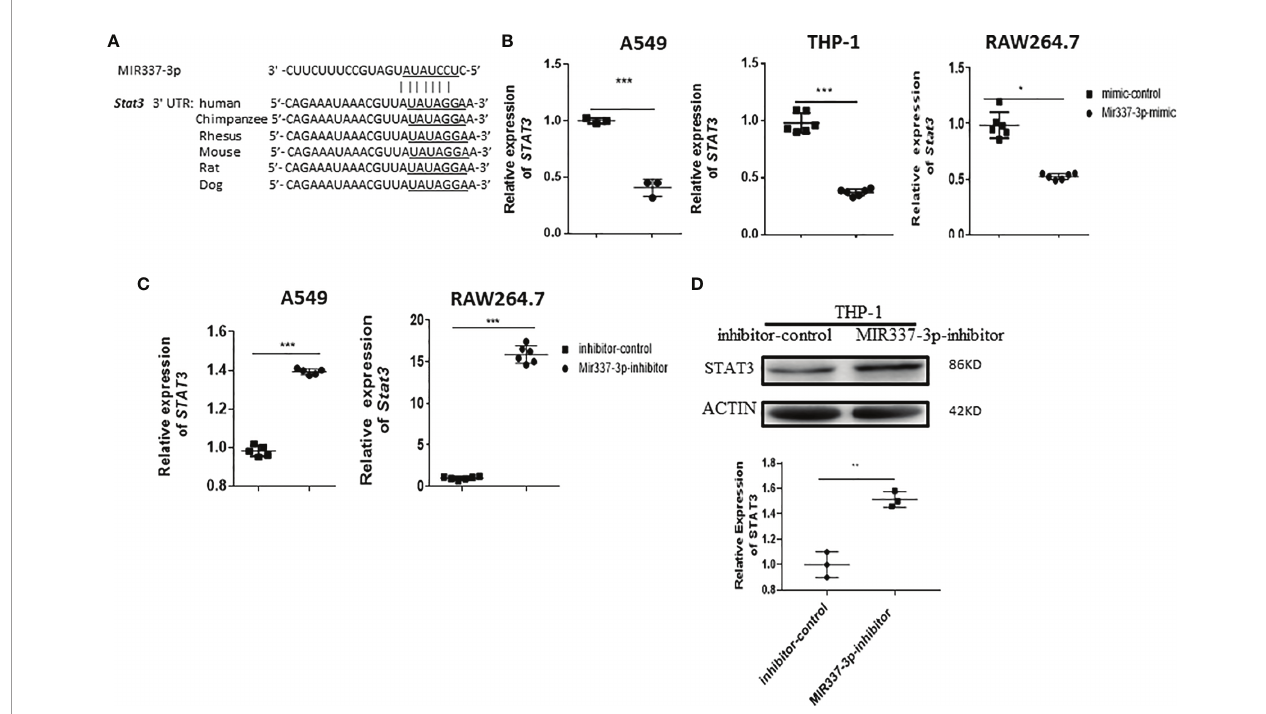
FIGURE 7 | Mycobacterium -driven MIR337-3p could depress STAT3 signal by targeting STAT3 3 ′ -UTR. (A) shows the binding sites of MIR337-3p in 3 ′ -UTR of STAT3 predicted by TargetScan software. (B) shows that transfection of MIR337-3p/Mir337-3p mimics led to downregulation of STAT3/Stat3 in BCG-infected human lung alveolar epithelial A549 cells, human THP-1, and mouse RAW264.7 macrophages, respectively. (C) shows that transfection of MIR337-3p/Mir337-3p inhibitors increased the expression of STAT3/Stat3 in BCG-infected A549 and RAW264.7 cells, respectively. (D) shows representative WB result indicating that MIR337-3p inhibitors enhanced STAT3 protein expression in THP-1 cells. Data are represented as mean ± standard errors. *P < 0.05, **P < 0.01, and ***P <